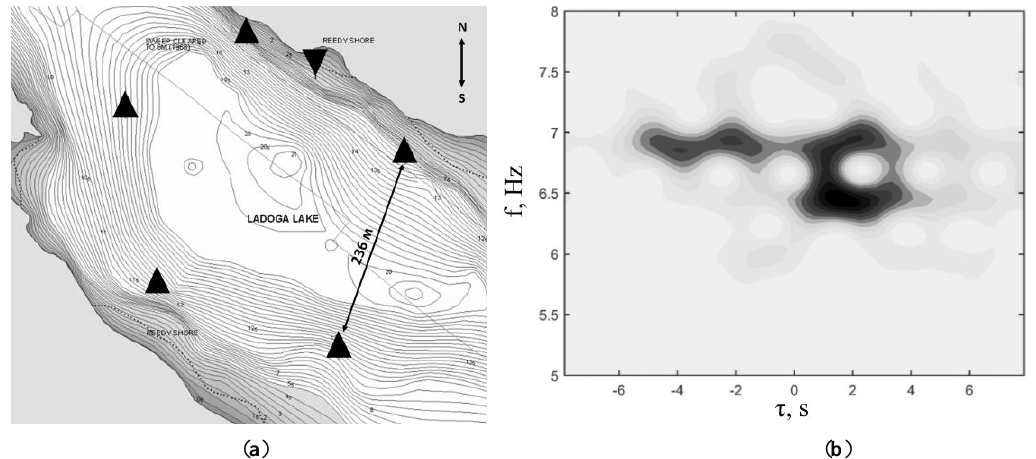
Figure 8. ( a ): Diagram of unique tomographic measurements performed using geohydroacoustic buoys (indicated by triangles, where the inverted triangle indicates the central base measuring station) from the ice cover taken in 2018; ( b ): spectrogram of the cross-correlation function of seismoacoustic noise, averaged over 8 h, recorded by buoys frozen in ice.